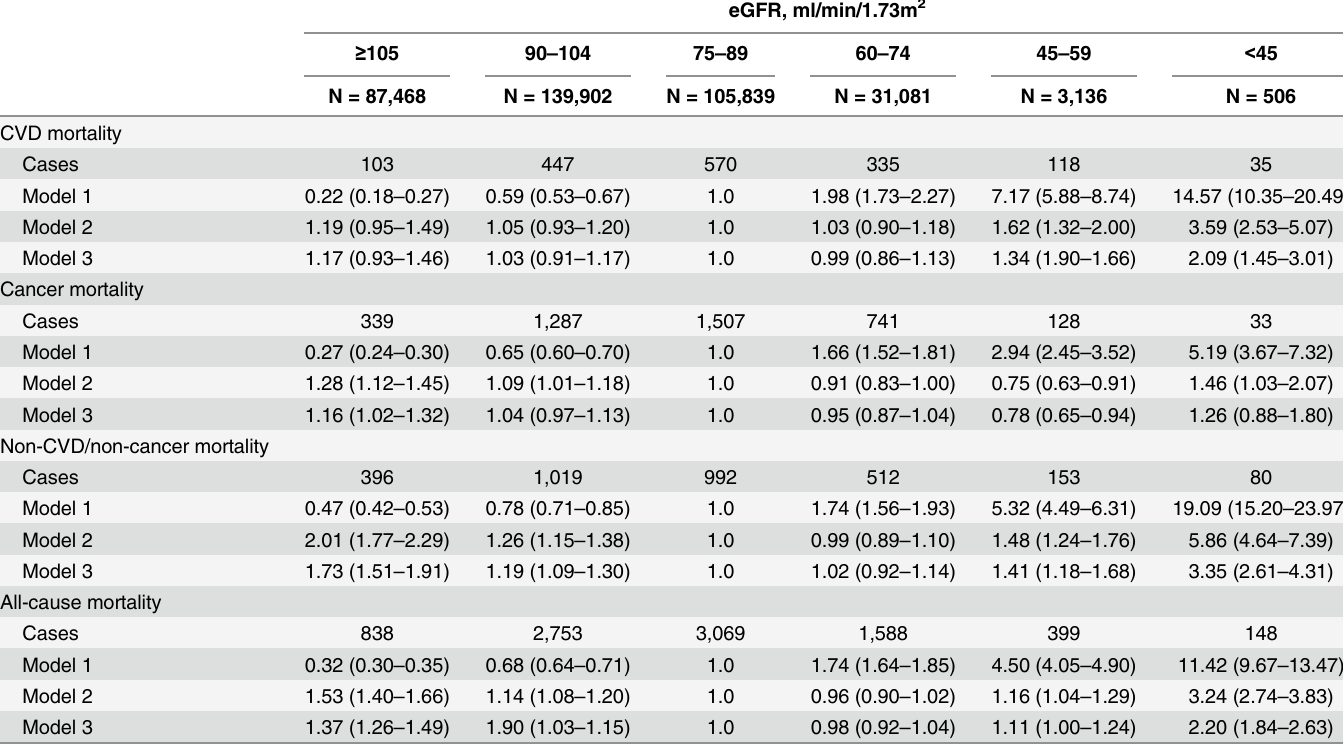
eGFR, ml/min/1.73m